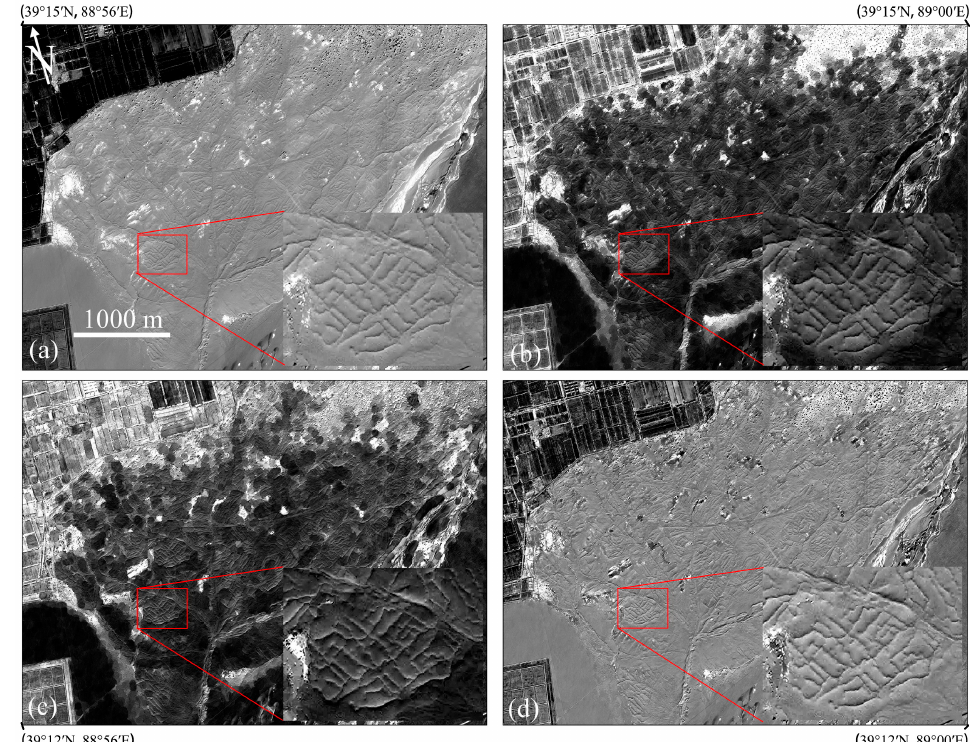
Figure 7. Morphological enhancement results for the GF-1 PAN image containing a disk-like structural element (disk radius = 20 pixels): ( a ) original image; ( b ) original image after top-hat transformation; ( c ) original image after bottom-hat transformation; and ( d ) original image after top-hat − bottom-hat transformation. The red box indicates the experimental site.